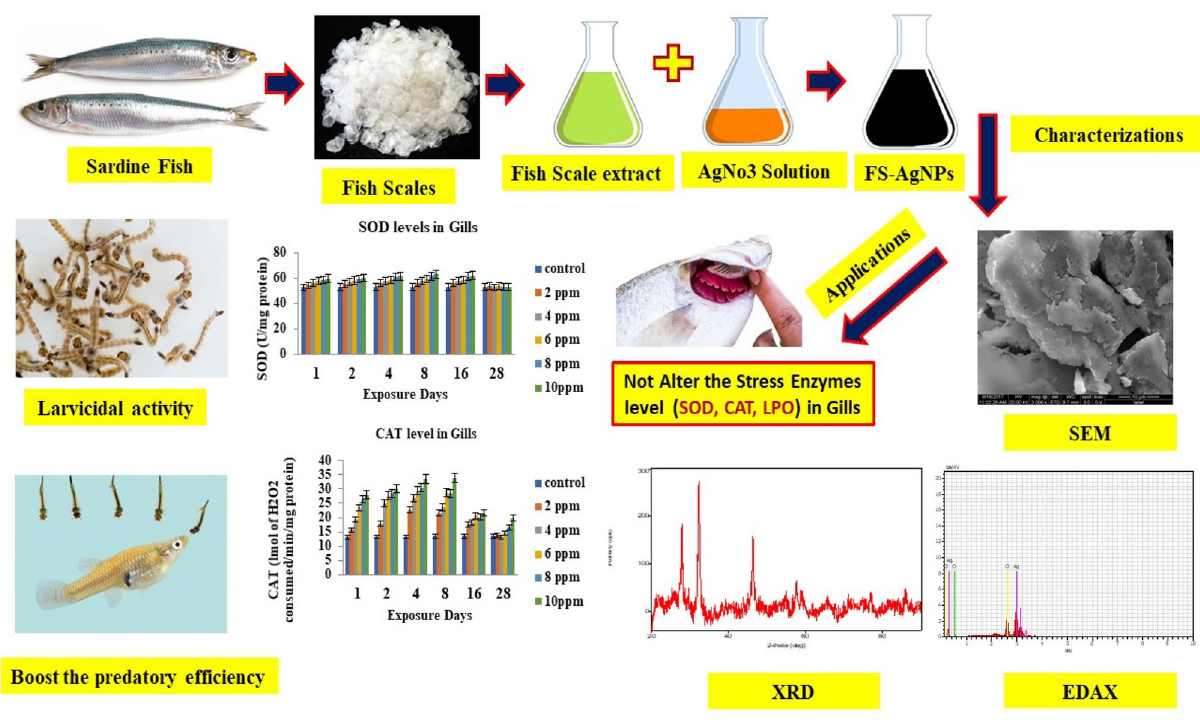
Figure 1. Pictorial representations of the salient steps of this